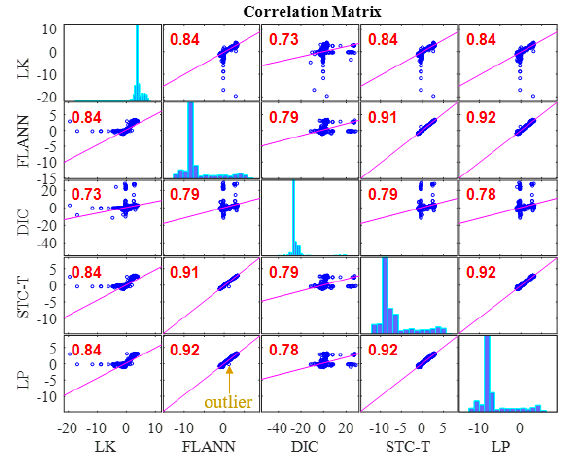
Figure 21. Correlation matrix of time displacement histories of Case 3 (fog interference).